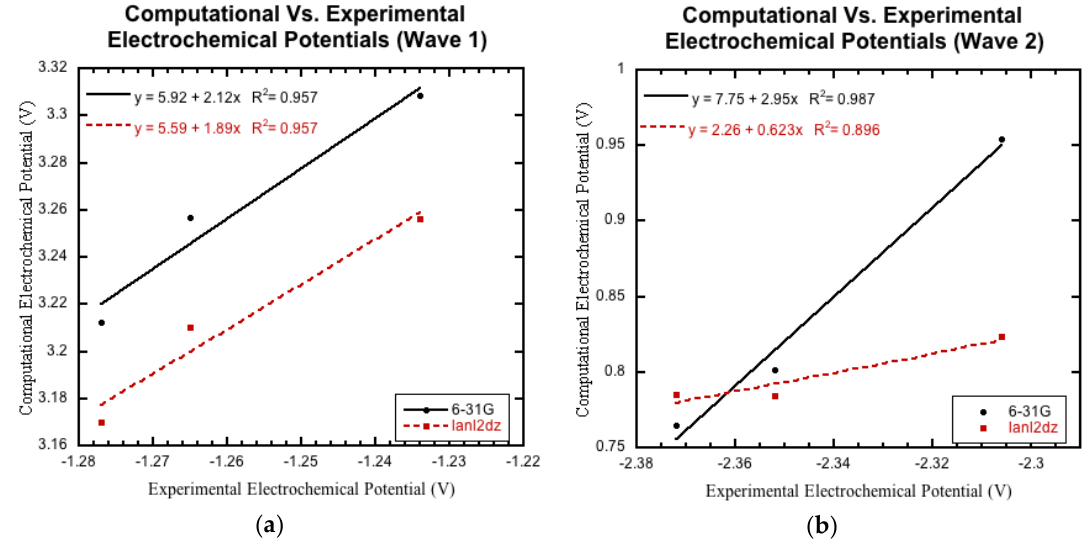
Figure 8. The computationally derived reduction potentials for ( a ) Wave 1 (1st N-oxide reduction) and ( b ) Wave 2 (2nd N-oxide reduction) compared to the previously reported experimentally measured data [27]. The basis set for lanl2dz is shown in red and 6-31G basis set is shown in black. Derivatives E1–E3 included.